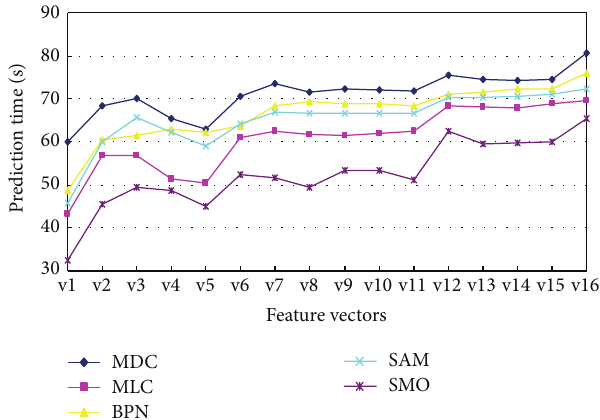
Figure 6: The effect on overall classification accuracy by different feature vectors and classification methods (experimental zone 1).